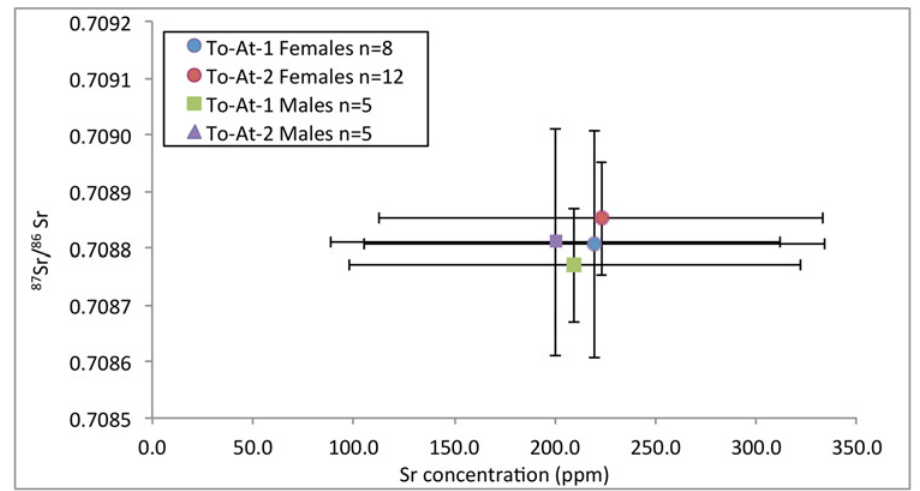
Fig 9. Mean ( ± 1SD) 87 Sr/ 86 Sr ratios for sex and burial